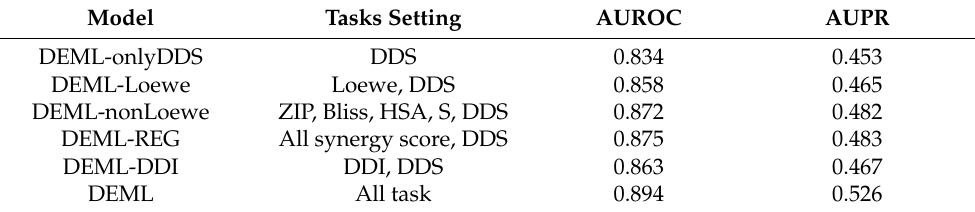
Table 1. Prediction performance of DEML tasks with different task transfer. Model Tasks Setting AUROC